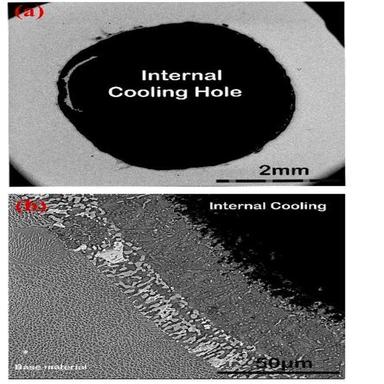
The degraded internal coating after long time operation (55,000 h) at the 50% height of TE.